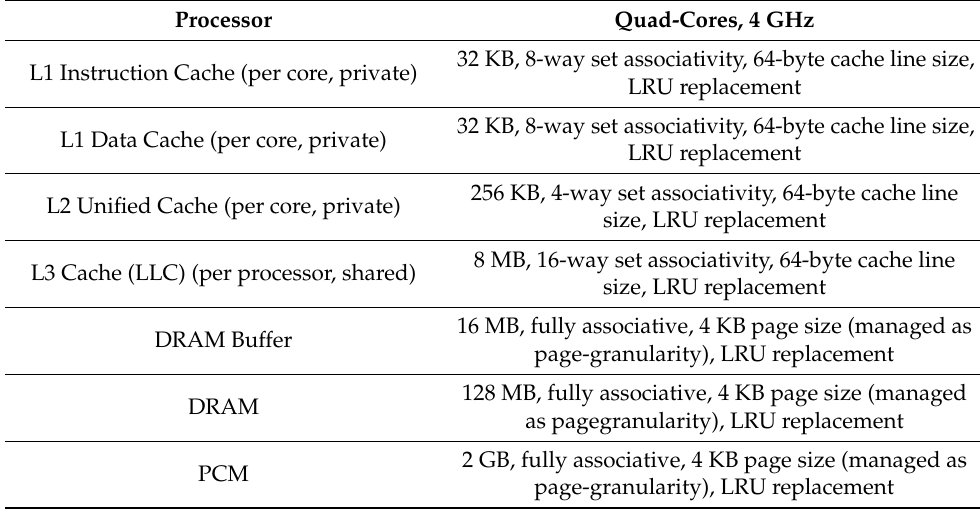
Table 3. Graph Processing Workloads.